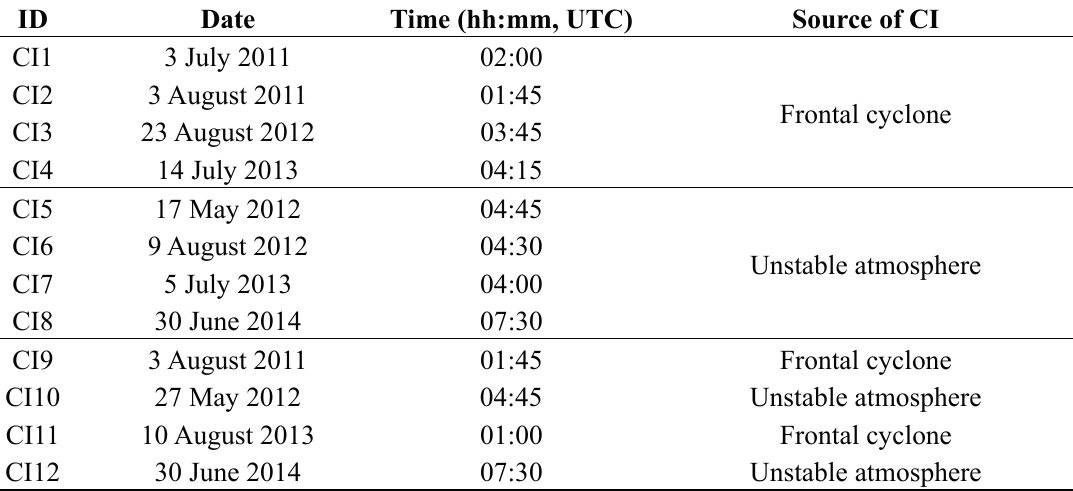
Table 3. Cases of convective initiations used for development and validation of machine learning based CI detection